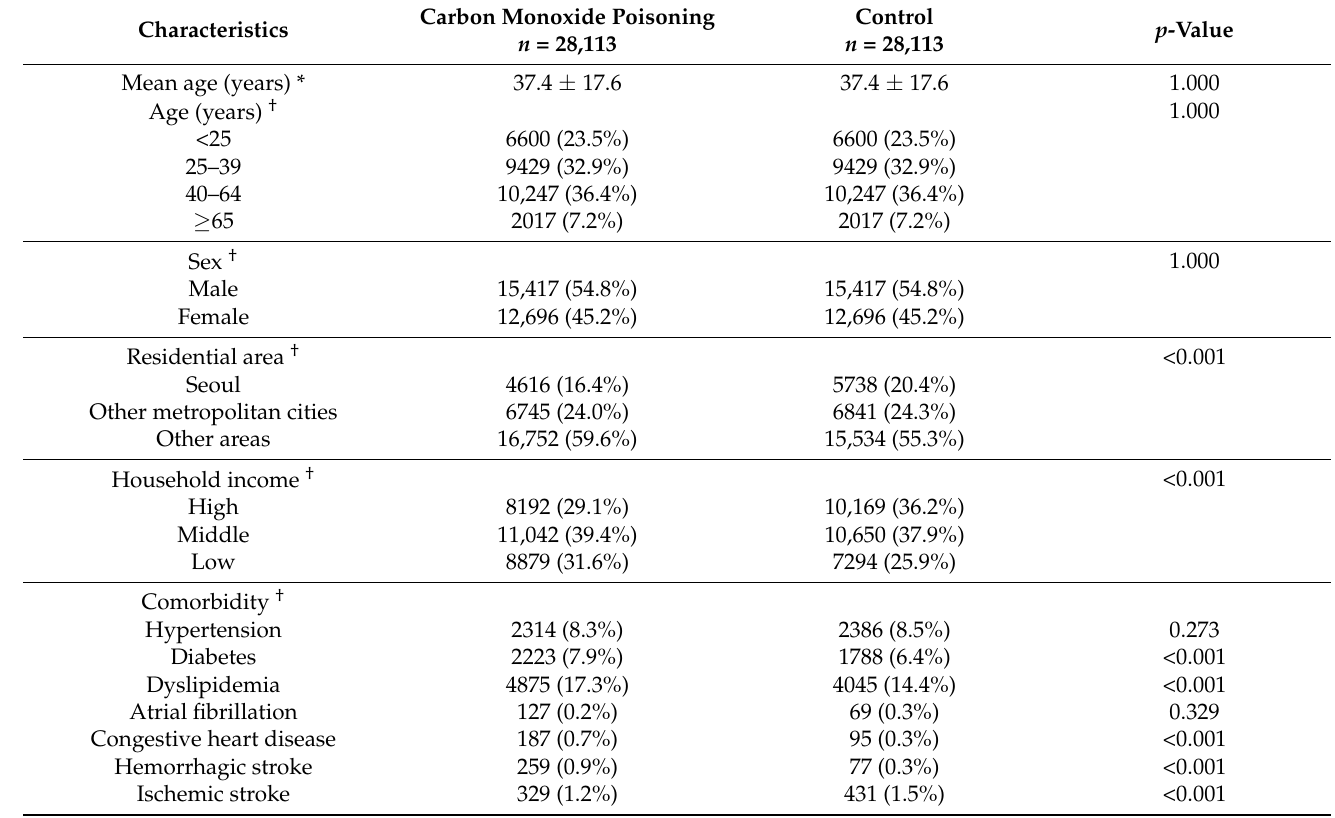
Table 1. General characteristics of the